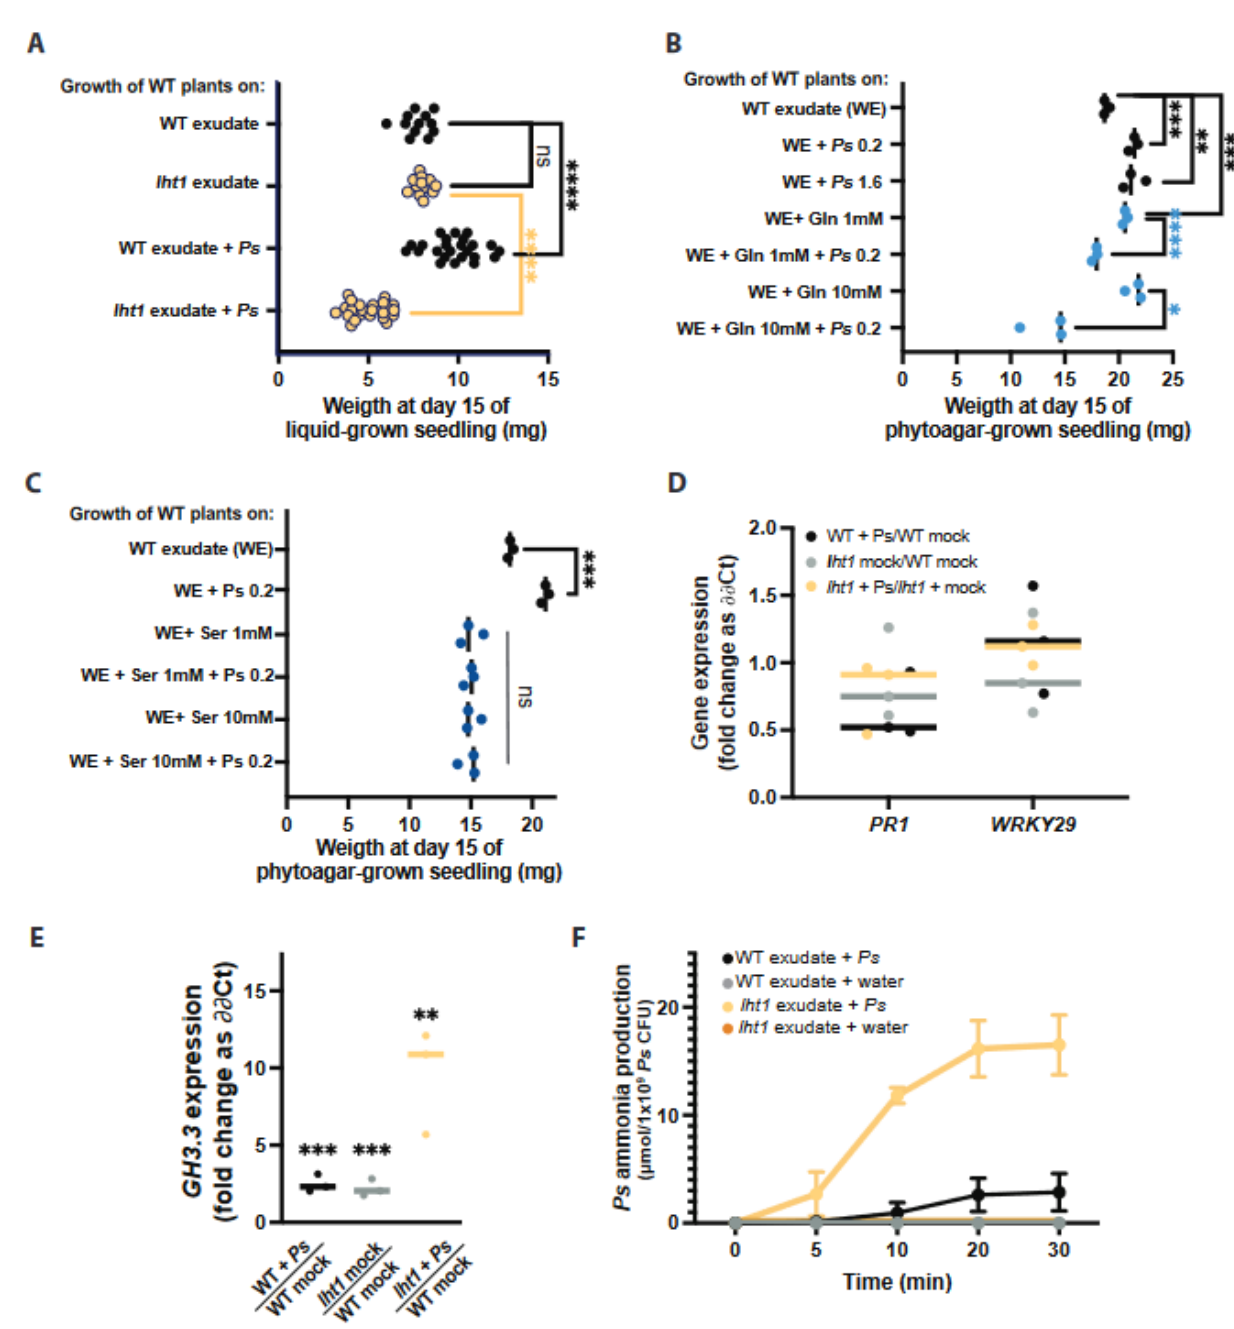
Figure 4. Excess AAs in lht1 exudates combined with Ps WCS417r inhibit wild-type Arabidopsis growth. Across all panels, each dot represents an independent biological replicate. The median of all biological replicates is depicted as a bar. A two-sided Student’s t -test was performed for statistical comparison of two means or a Welch’s t -test for two means with unequal variances. For comparison of more than two means, a one-way ANOVA followed by Tukey’s posthoc test, or a Kruskal–Wallis test for unequal variances followed by Dunn’s posthoc test was performed. The p -values are represented as * ≤ 0.05, ** ≤ 0.01, *** ≤ 0.005, and **** ≤ 0.001. Further experimental and analysis details are described in the Methods section. ( A ) The lht1 exudates inhibit the growth of wild-type Arabidopsis when inoculated with Ps WCS417r. Fifteen-day-old wild-type seedlings growing on 12-well plates with floating mesh on WT or lht1 exudate with or without Ps WCS417r OD 600nm = 0.2. Each dot represents the median weight of ≥ 3 seedlings per condition. The experiment was repeated 6 times; the median of all biological replicates is depicted as a bar. ( B ) Gln-supplemented WT exudates